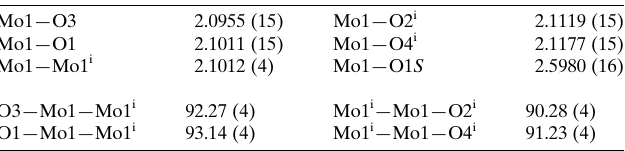
Table 1 Selected geometric parameters (A˚ , (cid:4) ).